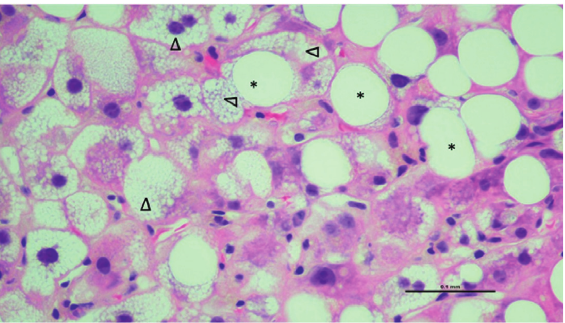
Figure 1: High power, hematoxylin and eosin (H&E) stained section of microvesicular (arrowheads) and macrovesicular (as- terisk) steatosis.